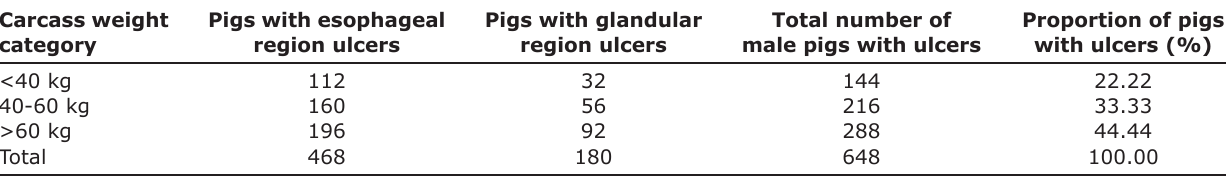
Table-7: Location of pig gastric ulcers according to carcass weight category. Carcass weight category